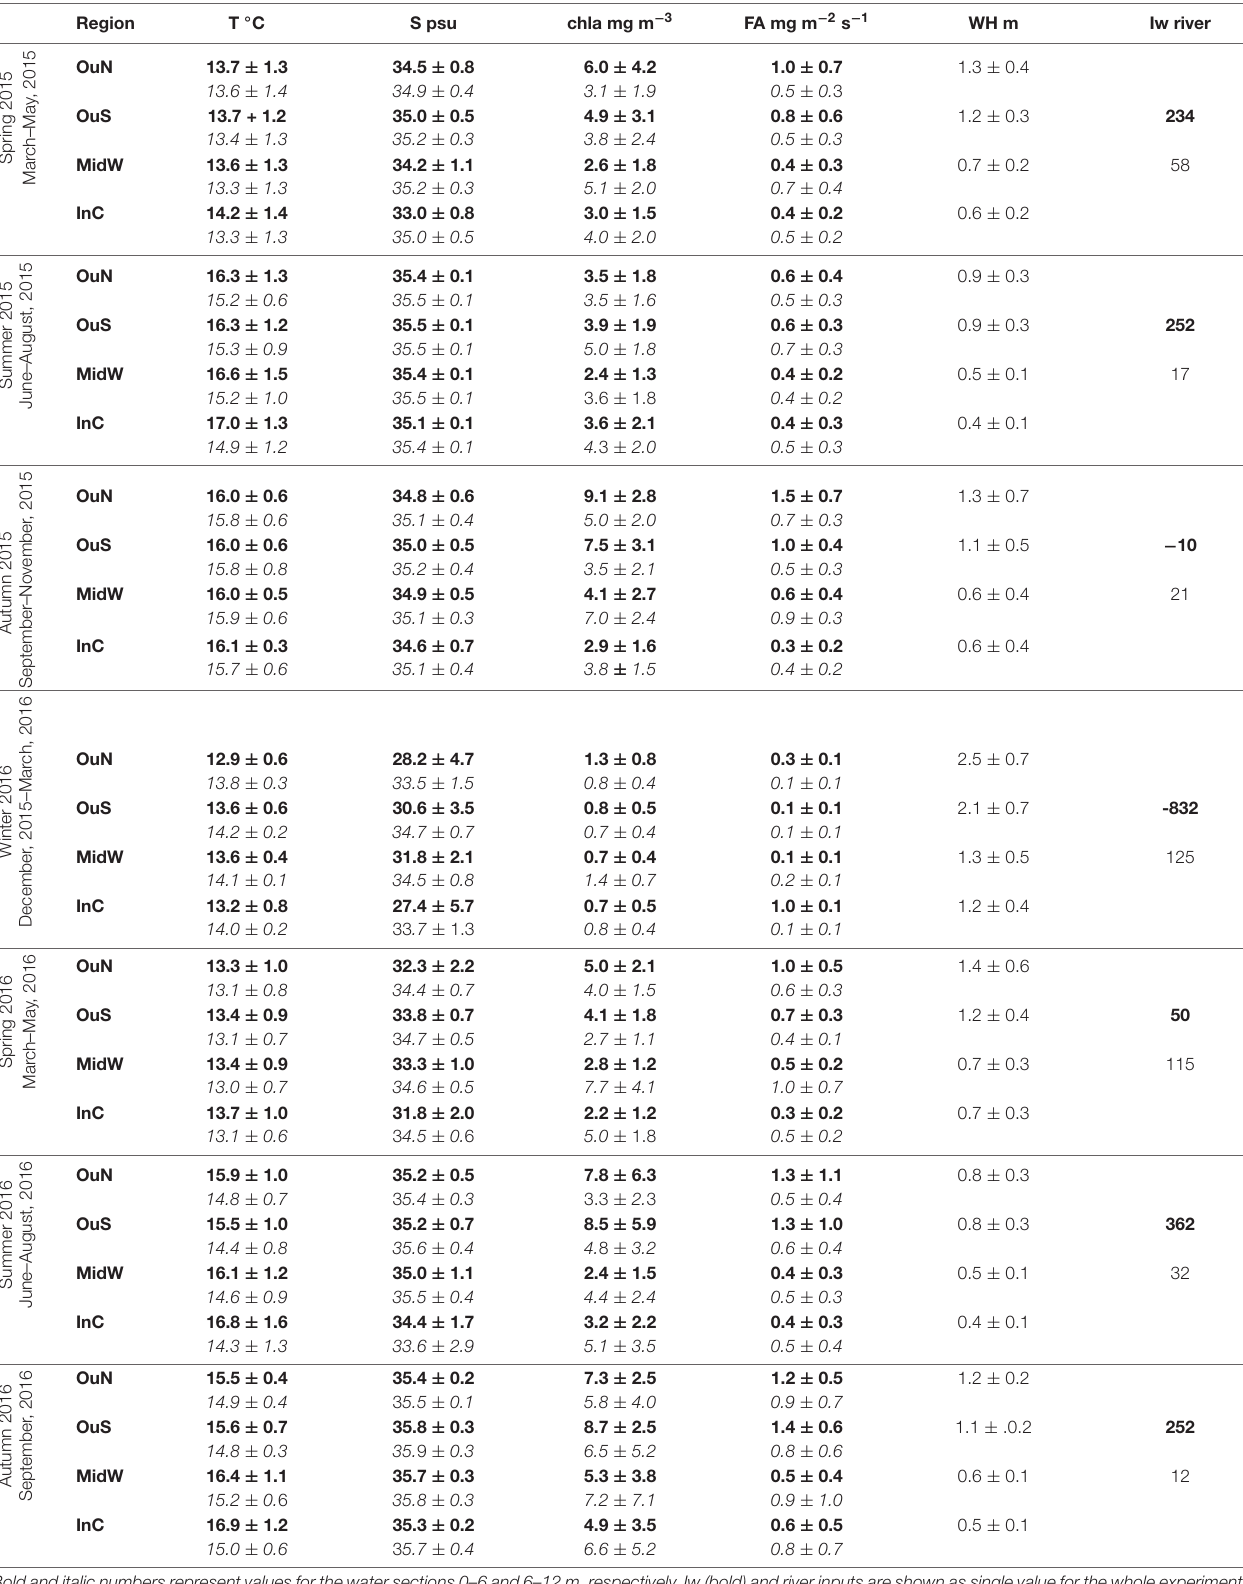
TABLE 1 | Variability of the environmental parameters temperature ( ◦ C), salinity, chl- a (mg m − 3 ), food availability (FA, mg m − 2 s − 1 ), wave height (m), upwelling index (10 3 m 3 km − 1 s − 1 ) and river input (m 3 s − 1 ) in the different sites of cultivation and as a function of experimental time.